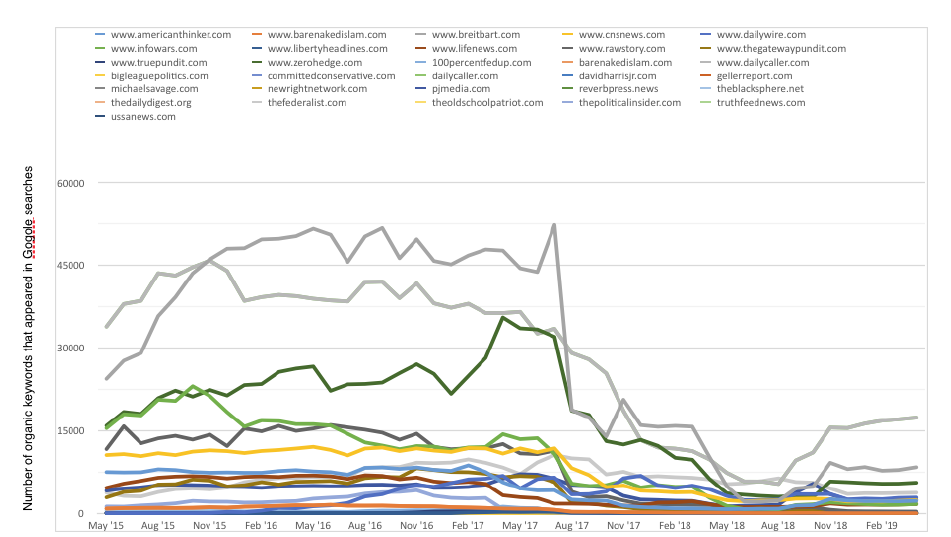
Figure 6: Estimated organic results for the top 29 junk news domains (May 2015- April 2019)